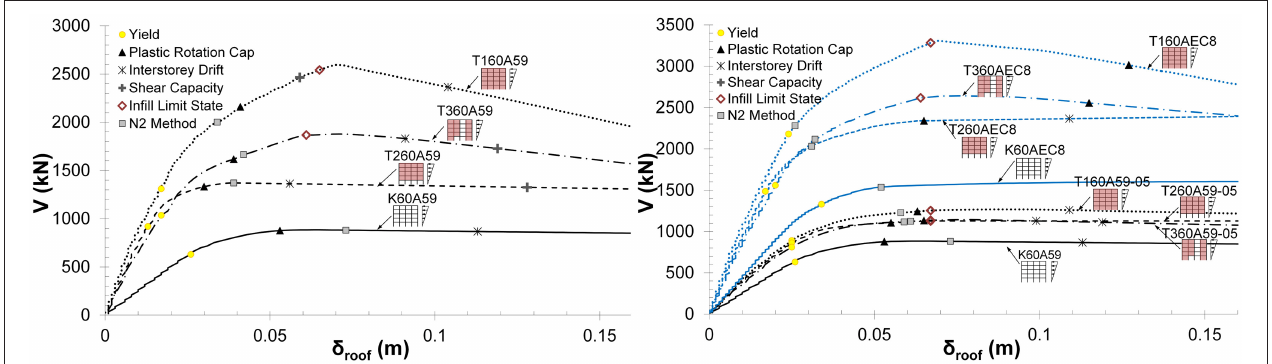
FIGURE 4 | Inelastic pushover (SPO) characteristics of bare and infilled frame structures K60A59 and K60AEC8.